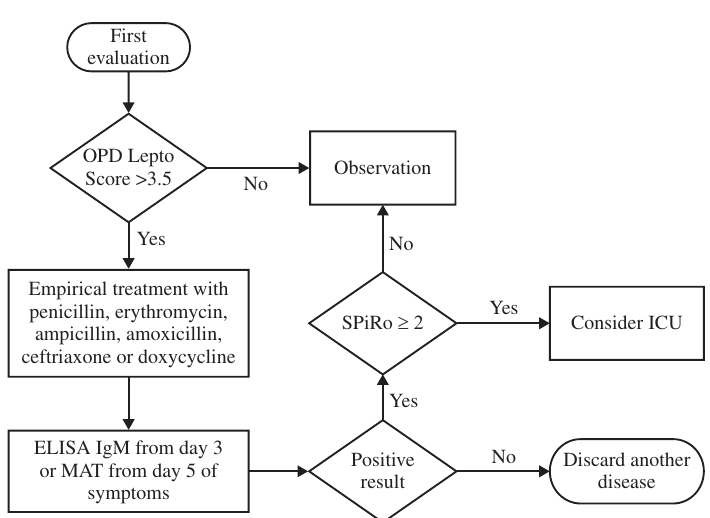
Figure 2. The diagnostic/treatment algorithm for patients at high risk of acquiring leptospirosis, defined as an OPD Lepto Score >